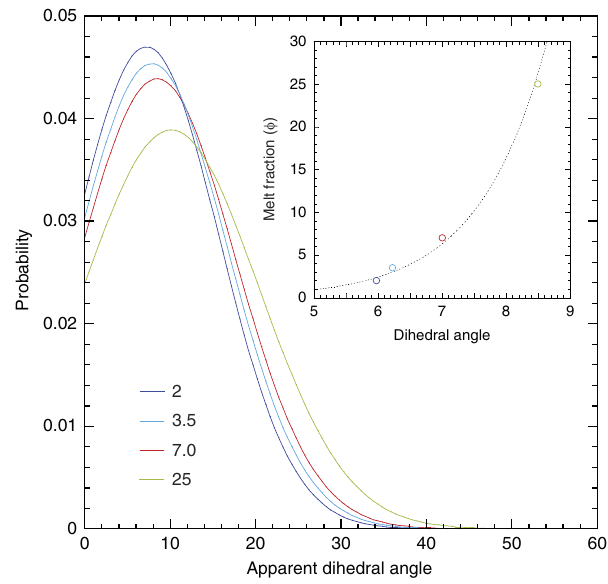
Apparent dihedral angle Fig. 3 The variation of dihedral angle with the melt fraction. The probability curves indicate a slight increase in dihedral angle with increasing melt fraction. The majority of melt occurs as melt- fi lled grain boundaries. A total of more than 50 measurements were used for the fi tting. (Inset) the change of dihedral angle with the melt fraction. The dihedral angle for the 0.7% melt fraction should be <